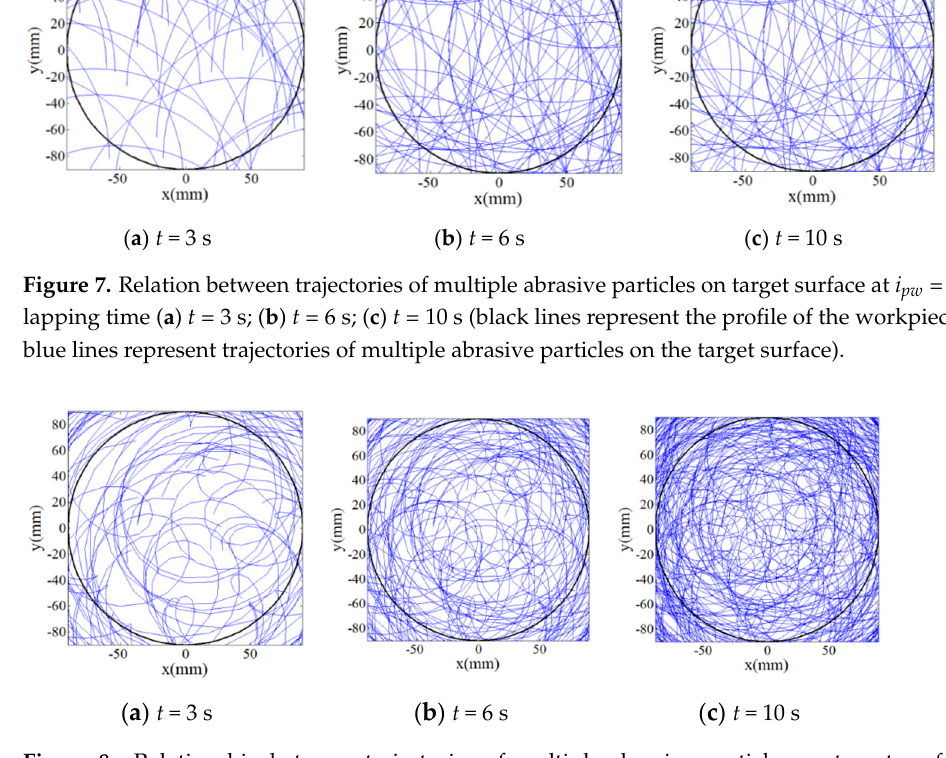
Figure 8. Relationship between trajectories of multiple abrasive particles on target surface at i pw = 0.3819… and lapping time ( a ) t = 3 s; ( b ) t = 6 s; ( c ) t = 10 s.